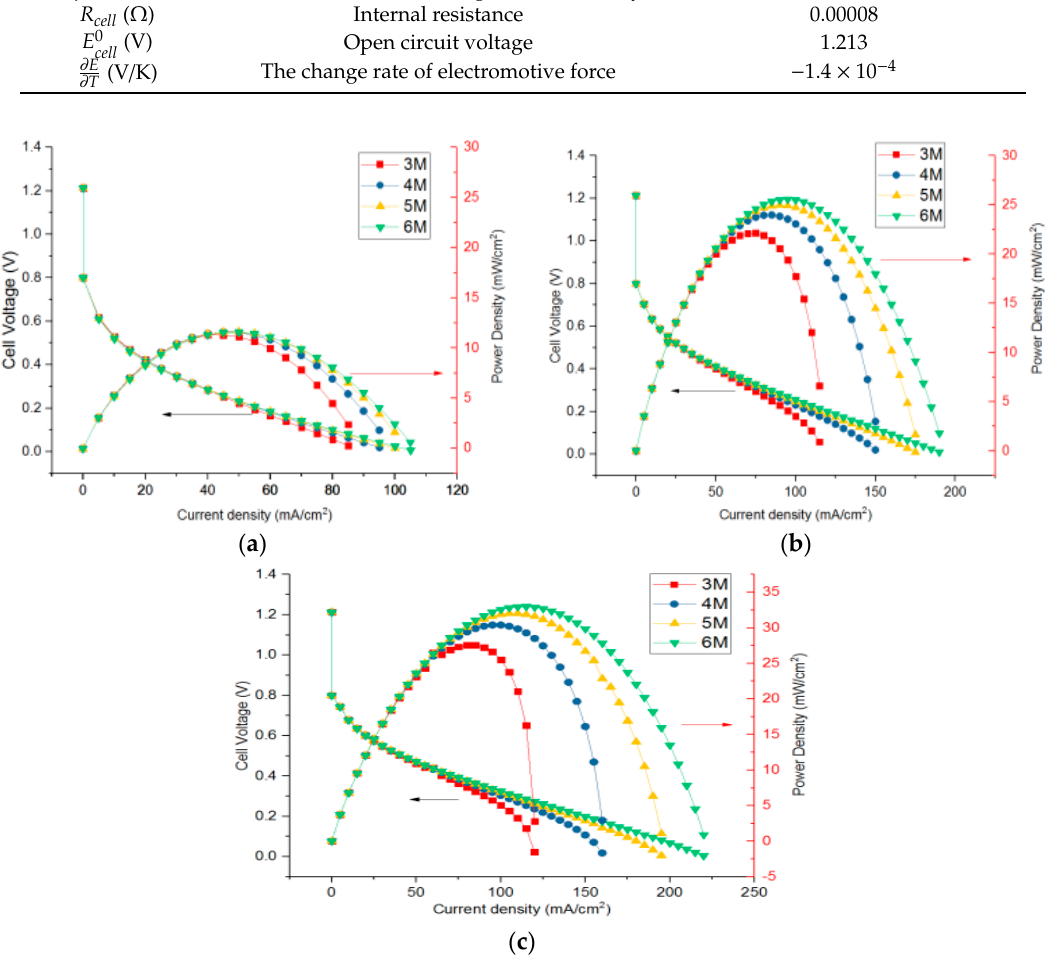
Figure 2. Output performance of the DMFC at di ff erent charge transfer coe ffi cients (CTCs). ( a ) α a is 0.35 and α c is 0.8. ( b ) α a is 0.45 and α c is 0.85. ( c ) α a is 0.5 and α c is